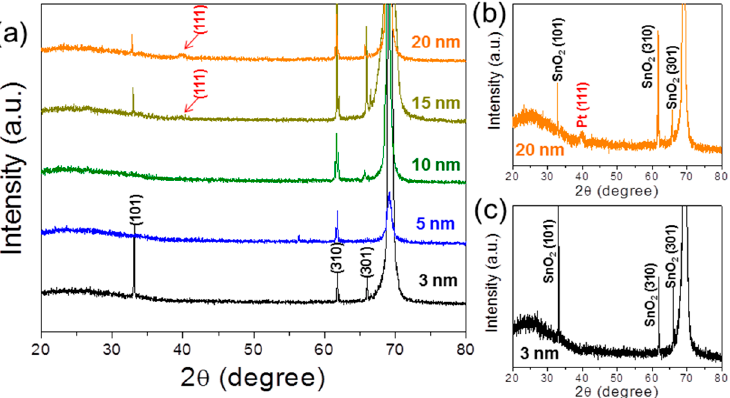
( c ) 3 nm-thick Pt layers.